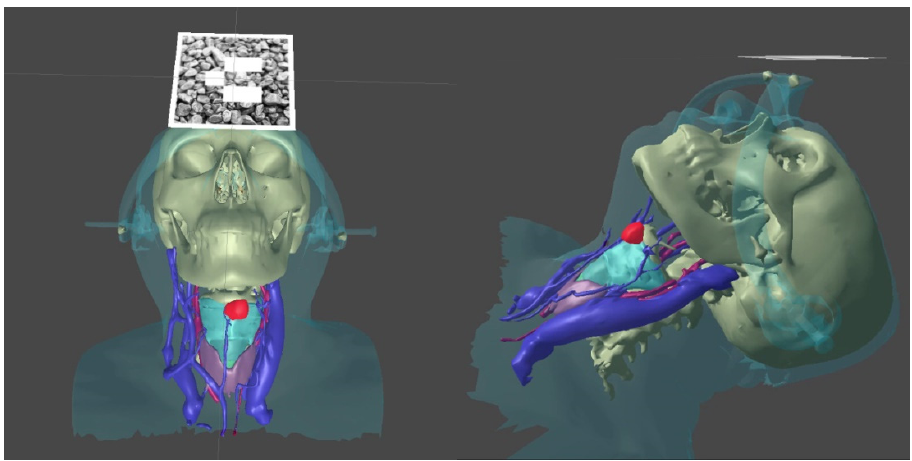
Figure 7. Construction of a 3D model of anatomical structures using the 3D Slicer.